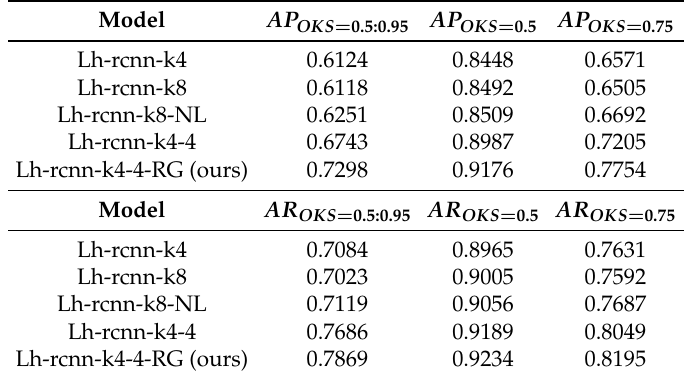
Table 4. Comparison of different keypoints head on Parrot outdoor dataset. For the explanations of each model, please refer to the text.